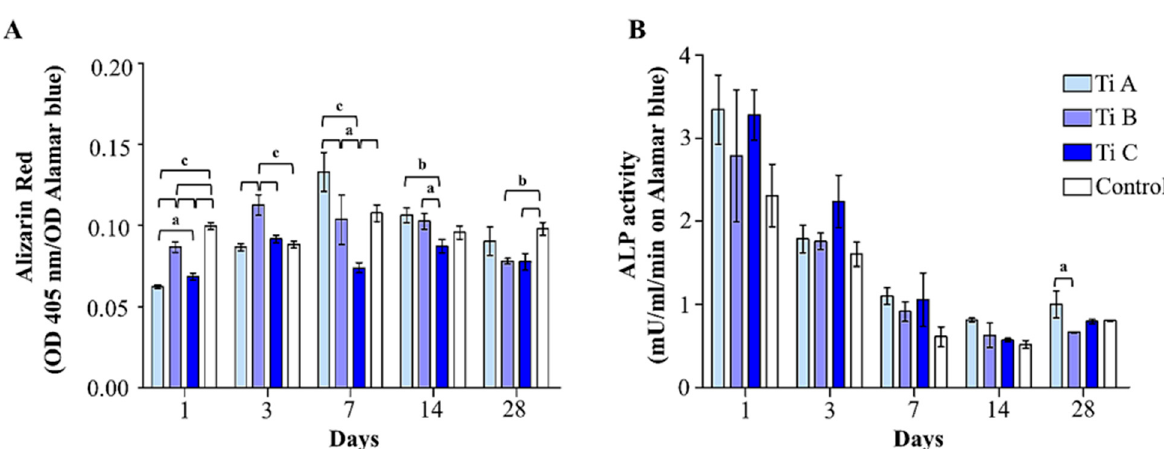
Figure 5. ( A ) Alizarin red staining representing OD values of solubilized orange-red stained calcium deposits/OD alamarBlue ratio. Data shown are the mean ( ± SD) of three separate experiments. ( B ) Quantitative evaluation of the ALP activity in DPSCs grown onto Titanium A, B, C and coverslip scaffold (control) for 1, 3, 7, 14, and 28 days. Values represent the means ± SD. Bar graph showing the enzymatic activity of ALP (U/mL) normalized on alamarBlue values. a = p < 0.01; b = p < 0.001; c = p < 0.0001.